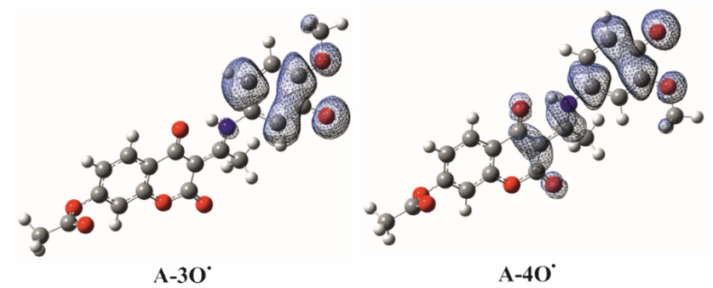
Figure 5. Spin density distribution maps (0.002 electron/bohr3) for formed radical species. The blue color represents the positive spin